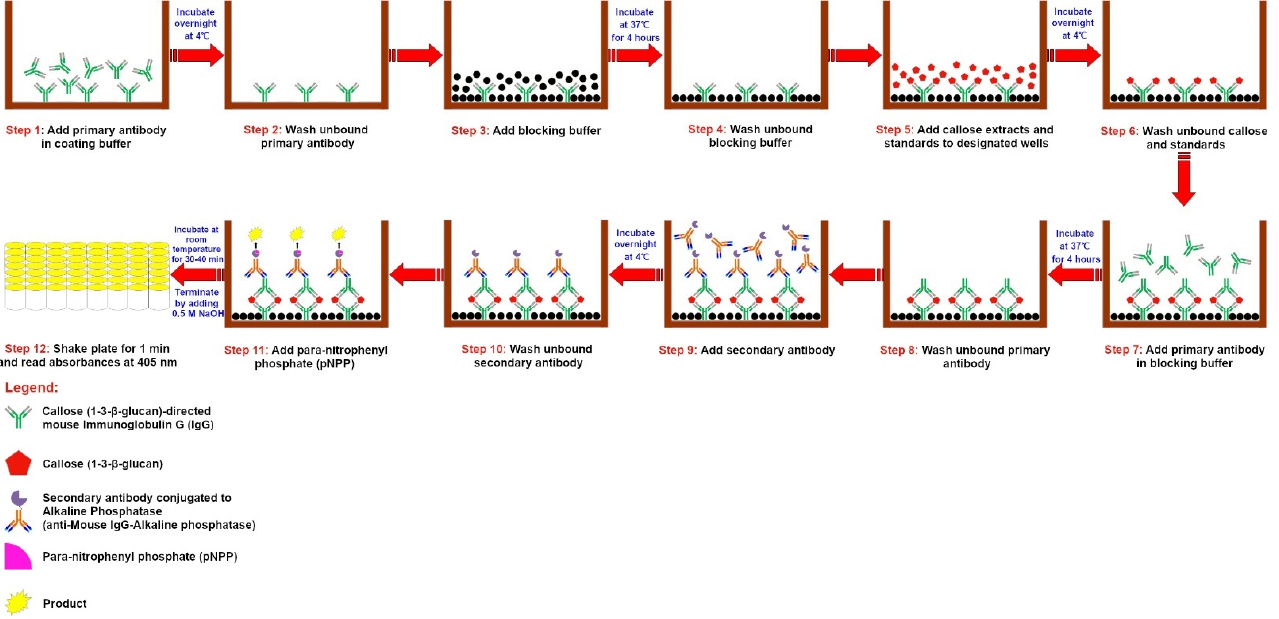
Figure 2. Schematic illustration of the Sandwich-Enzyme-Linked Immuno-Sorbent Assay (S-ELISA) for callose quantification.